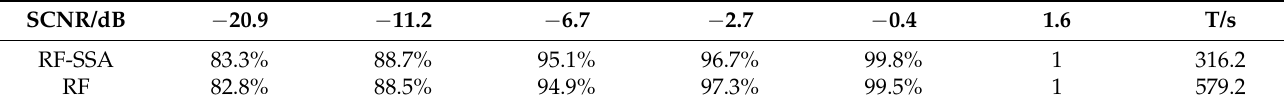
Table 2. Comparisons of average computational cost ( v = 0.1).